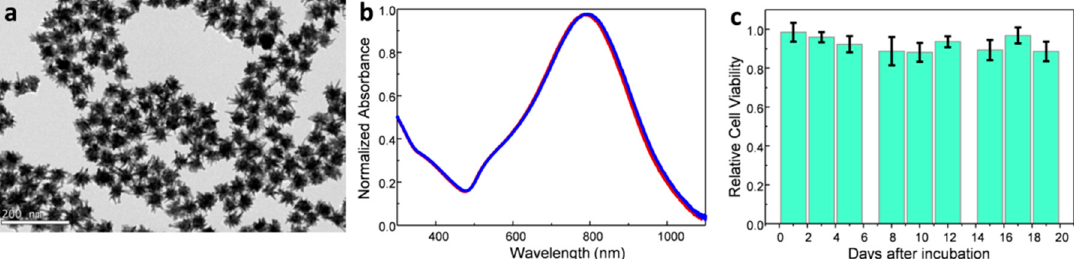
Figure 1. ( a ) TEM image of the synthetized Au NSs. ( b ) UV-vis-near-infrared (NIR) spectra of the gold nanostars (Au NS) colloidal solution with the localized surface plasmon resonance (LSPR) band at ca. 800 nm (red) and at 795 nm (blue), before and after transfer to physiological conditions, respectively. ( c ) Cell viability test after 12 h of incubation of Au NSs with uvea cells (3 independent samples were tested and averaged; the error bars show the standard deviation of the relative cell viability). The cell viability shows cell survival above 90% after 19 days.